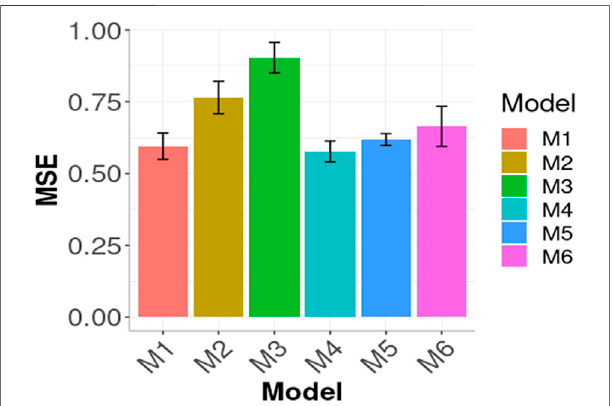
FIGURE 2 | Prediction performance in terms of Normalized Root Mean Squared Error of the six models (M1, M2, M3, M4, M5, M6) across environments (Global) in thewheatdata. M1denotes the generalized boosted machine model, M2 denotes the generalized linear model, M3 denotes the support vector machine model, M4 denotes the random forest model, M5 denotes the Bayesian regression model and M6 denotes the deep neural networks